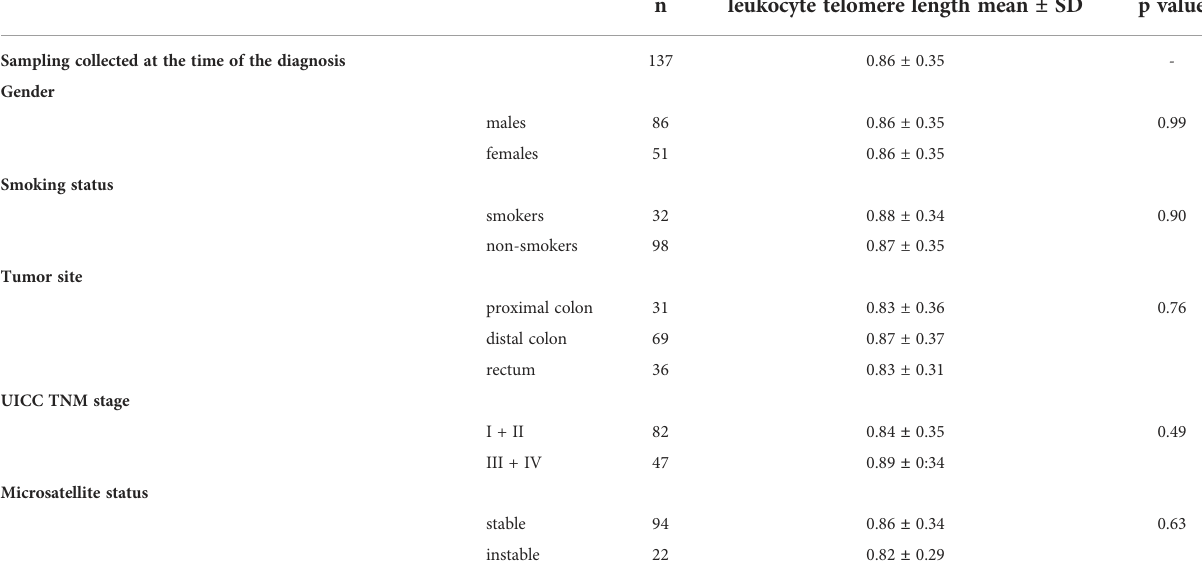
TABLE 3 Leukocyte telomere length in colorectal cancer patient subgroups at the time of the diagnosis. Clinicopathological characteristics of